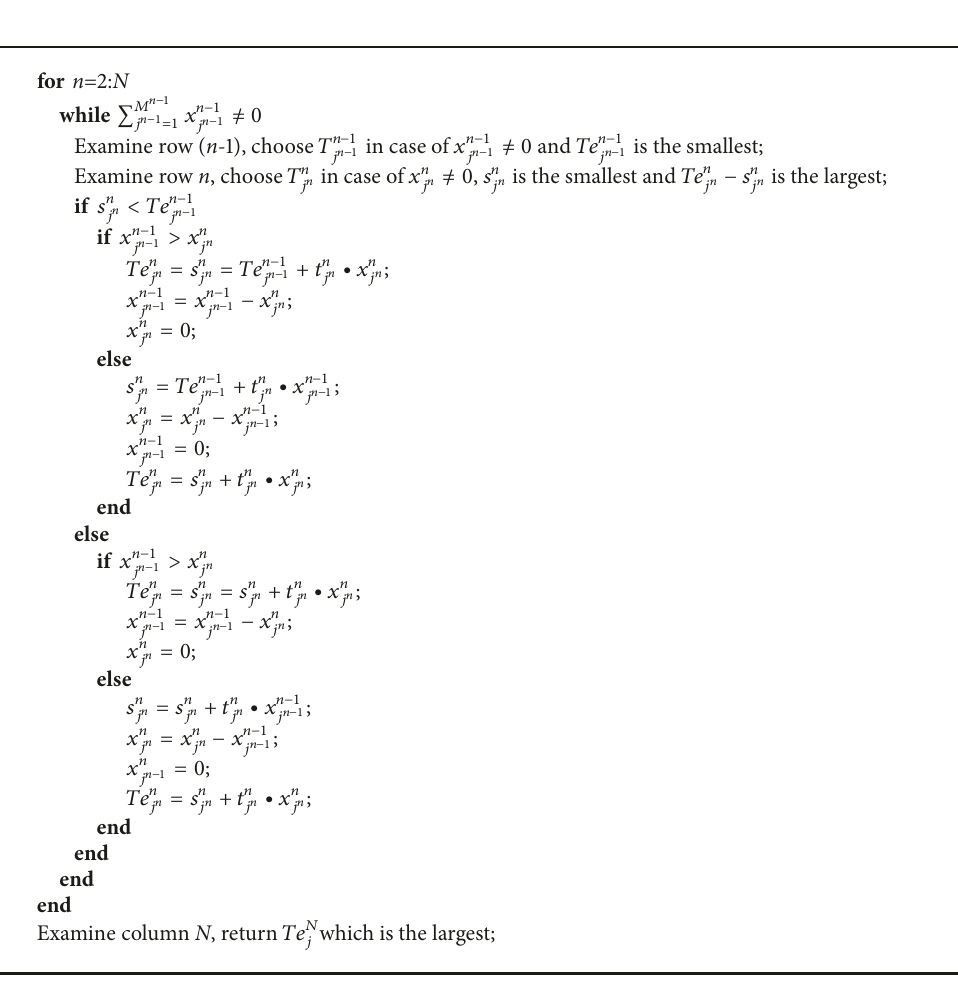
Algorithm 1: Algorithm of objective function. Table 4: The production time of every scheme (individual) in the last